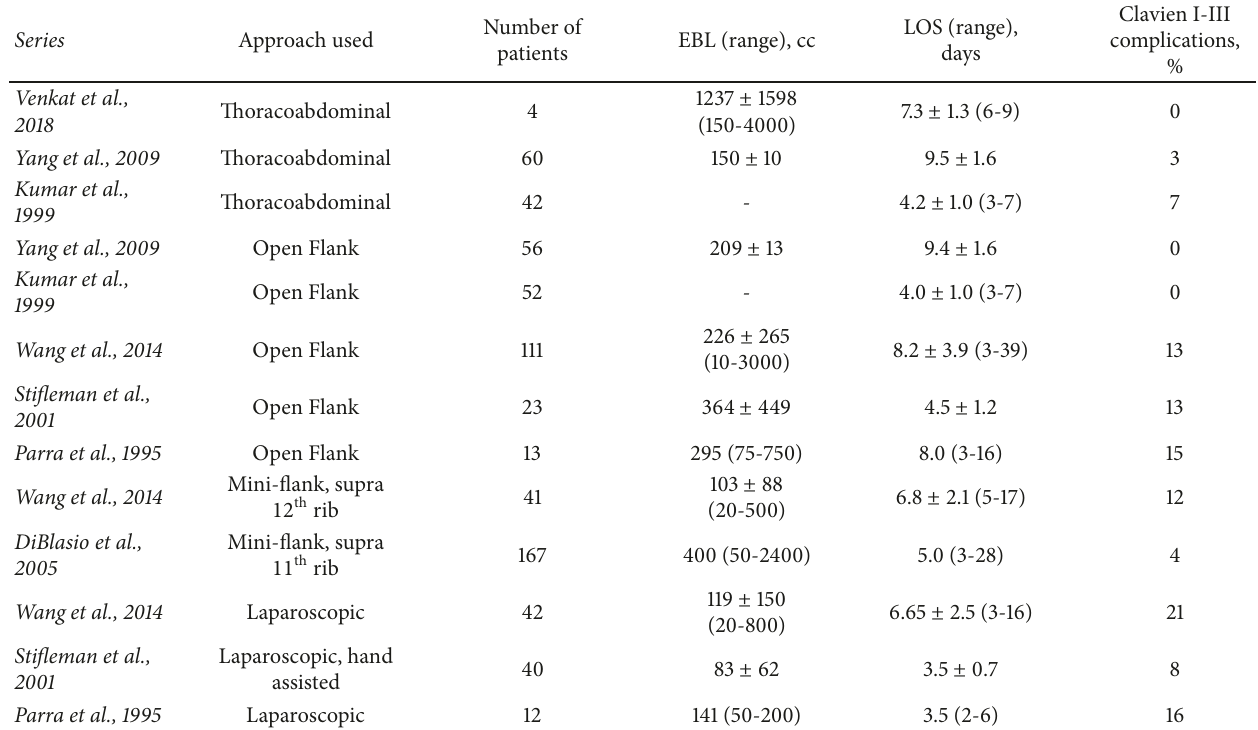
Table 1: Comparison of case series and surgical